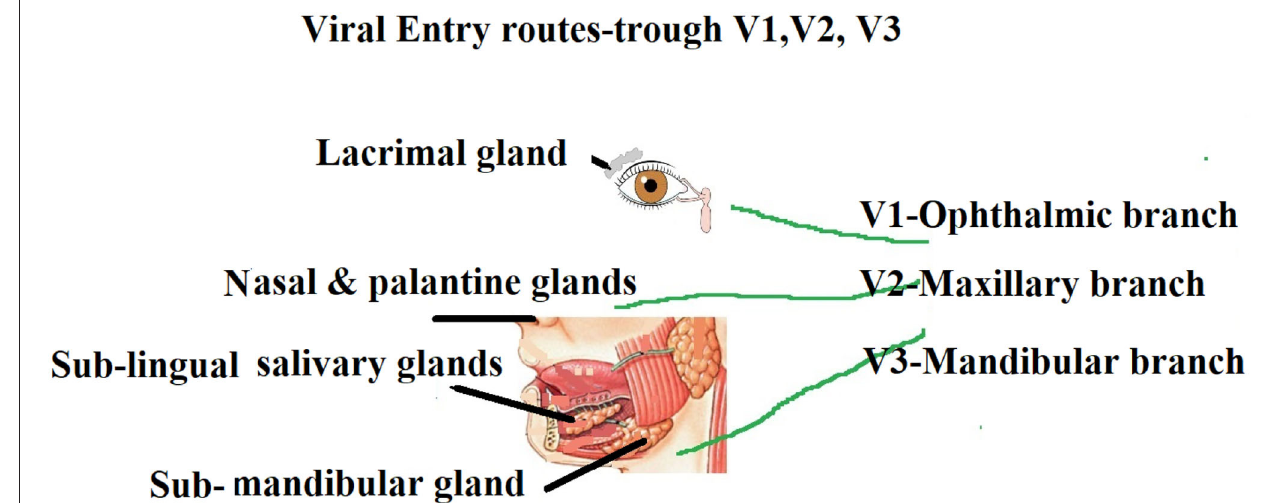
FIGURE 2 | SARS-CoV-2 entry through orofacial